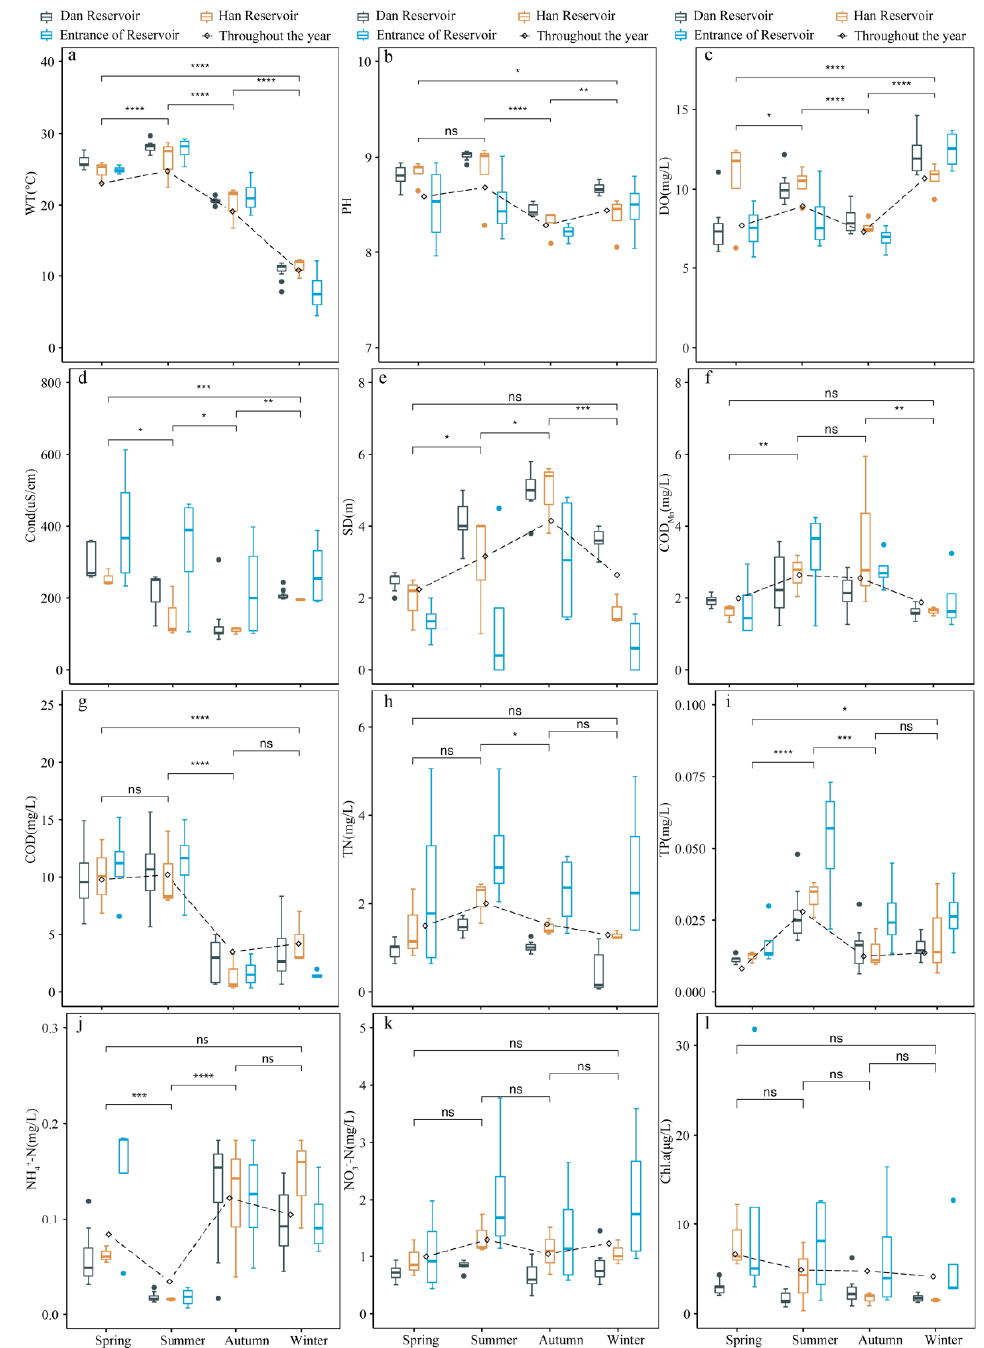
Figure 4. Seasonal variation of environmental factors in the Danjiangkou Reservoir: ( a ) WT, ( b ) pH, ( c ) DO, ( d ) Cond, ( e ) SD, ( f ) COD Mn, , ( g ) COD, ( h ) TN, ( i ) TP, ( j ) NH 4+ -N, ( k ) NO 3 − -N, ( l ) Chl.a; ns denotes p > 0.05; * indicates p < 0.05; ** denotes p < 0.01; *** denotes p < 0.001; **** denotes p < 0.0001.